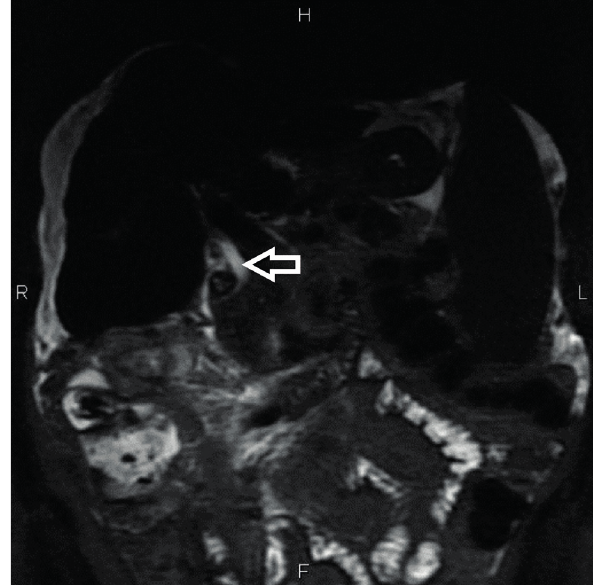
Fig. 5. MRCP with maghemite bowel preparation: 60-year-old woman with advanced liver cirrhosis, before liver transplanta- tion due to primary biliary cirrhosis. Sufficient suppression of the signal of bowel content is seen in the upper part of abdomen leading to better biliary ducts visualization after SPIO per-oral application (arrow).